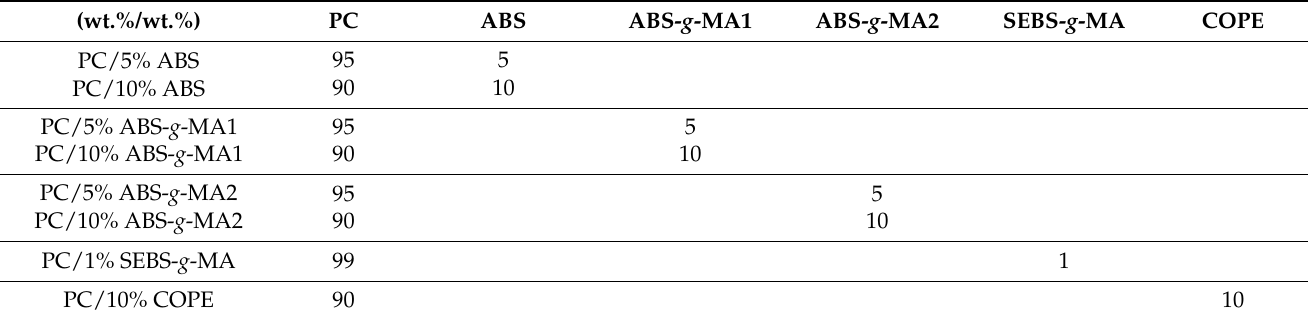
Table 2. Blend composition